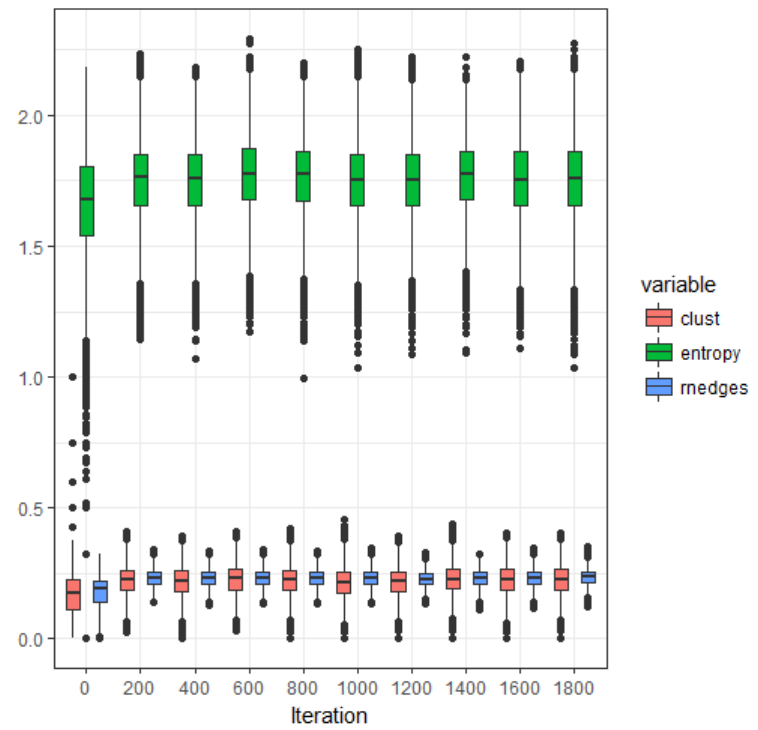
Figure 2. Estimated expected values of relative number of edges, clustering coefficient and sample degree distribution entropy, as a function of the iteration number ( p a = 0.3 and p r =